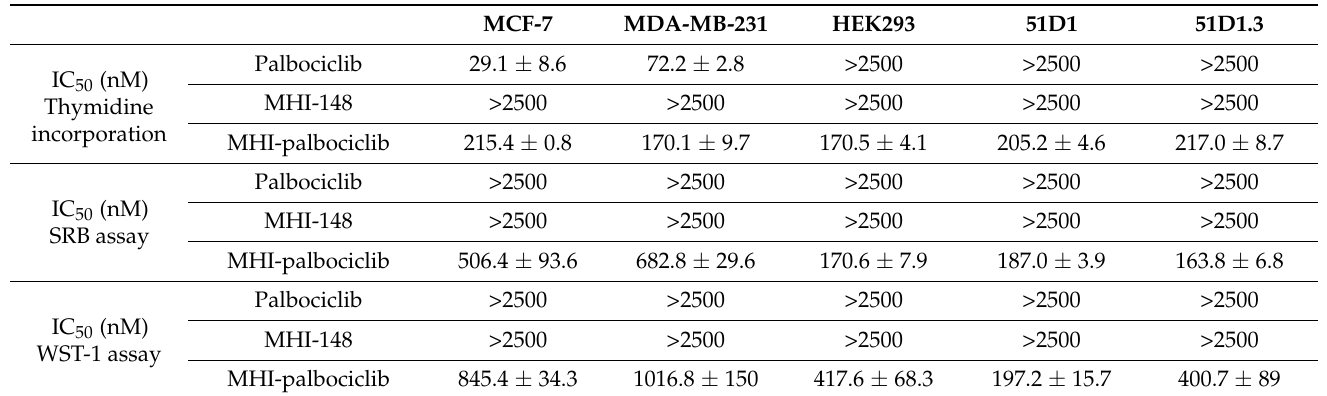
Figure 2. Effect of palbociclib, MHI-148 and MHI-palbociclib on ( A – C ) cell proliferation ([ 3 H]- thymidine incorporation assay), ( D – F ) cell growth (SRB assay), and ( G – I ) cell viability (WST-1 assay). Effects on breast cancer cell lines and non-cancerous cell lines were measured after 3 days of treatment with the compounds. Data presented are an average of at least three independent experiments. Table 1. IC 50 values of palbociclib, MHI-148 and MHI-palbociclib in breast cancer MCF-7 and MDA-MB-231 cell lines, and non-cancerous HEK293, 51D1 and 51D1.3 cell